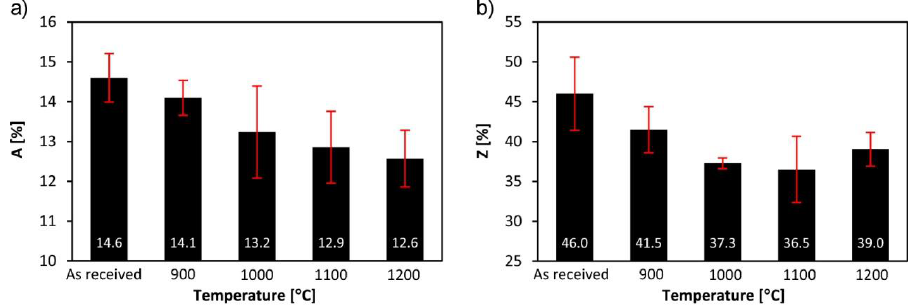
Figure 5. Percentage elongation ( a ) and percentage reduction of area ( b ) of the tested steel in the as-received state and after different austenitization temperatures.